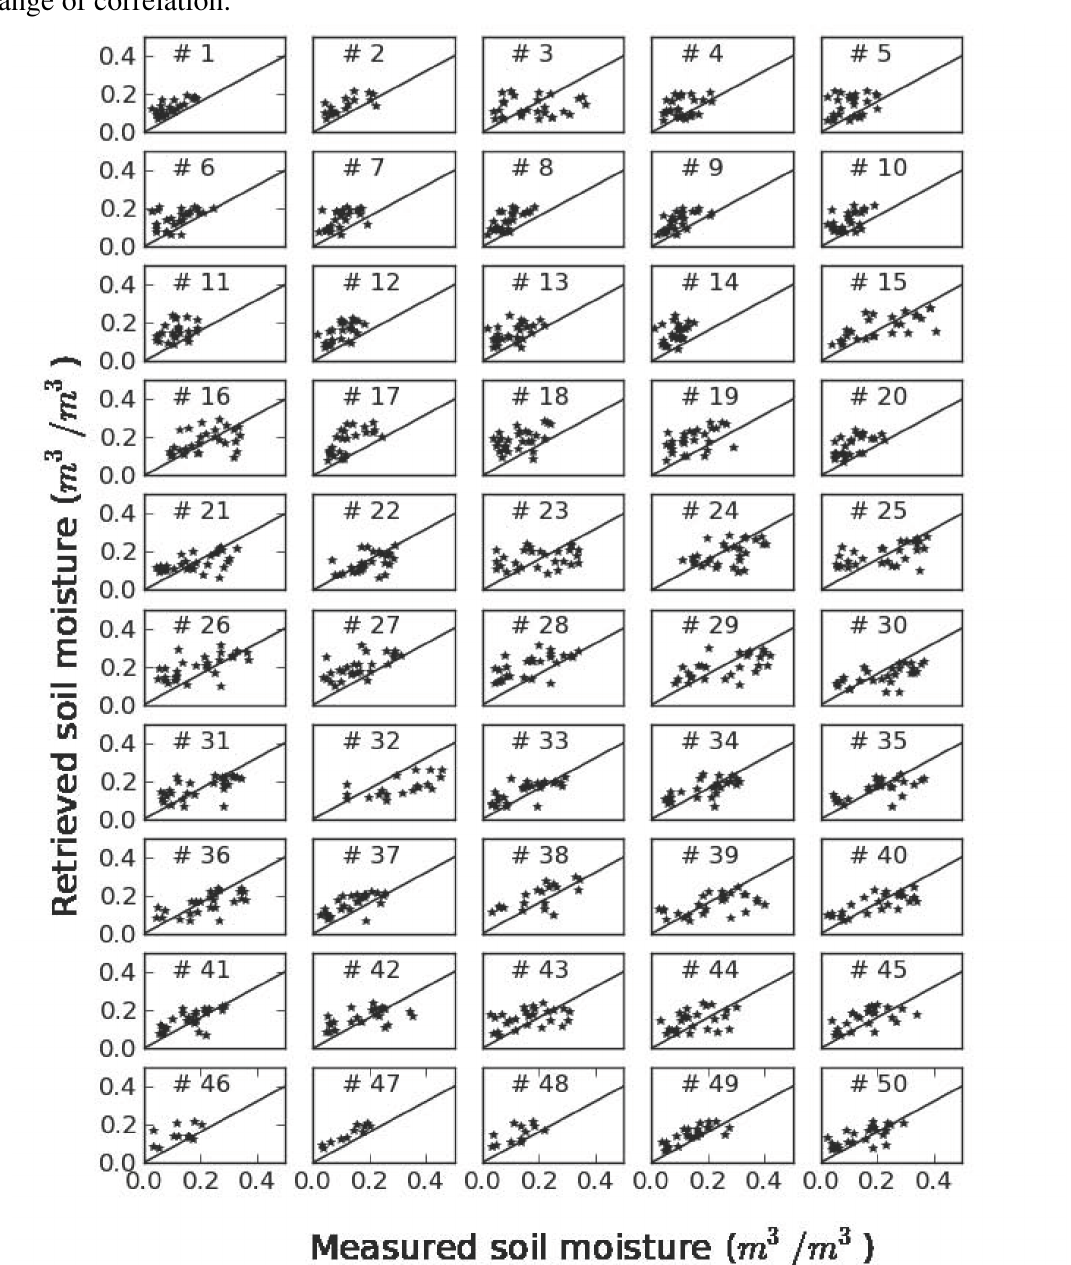
Figure 5. Scatter plot of the soil moisture retrieved using the CT model from the RADARSAT-2 against the field measured data in 50